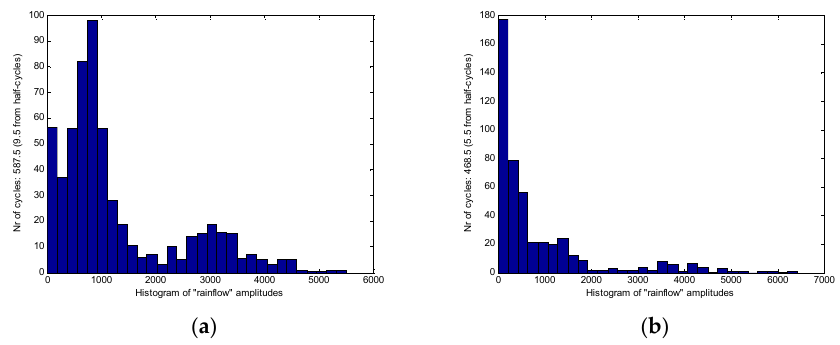
Figure 12. The amplitudes value of the F z , ( a ) On the standard road, ( b ) On the target road.